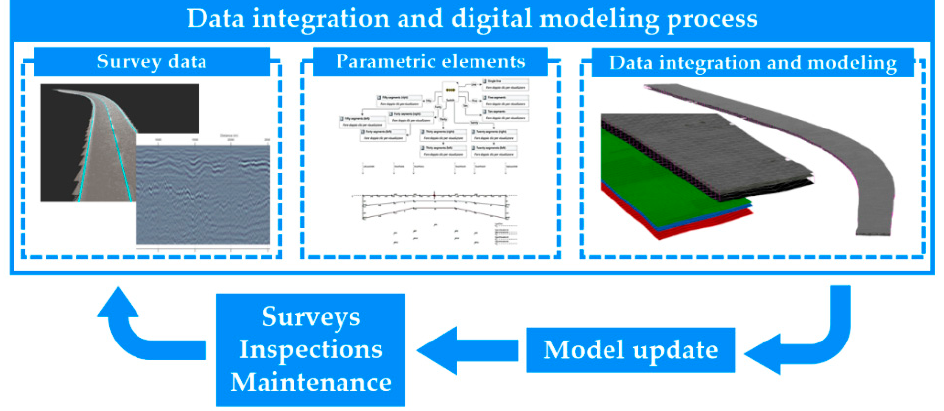
Figure 1. The methodological framework.